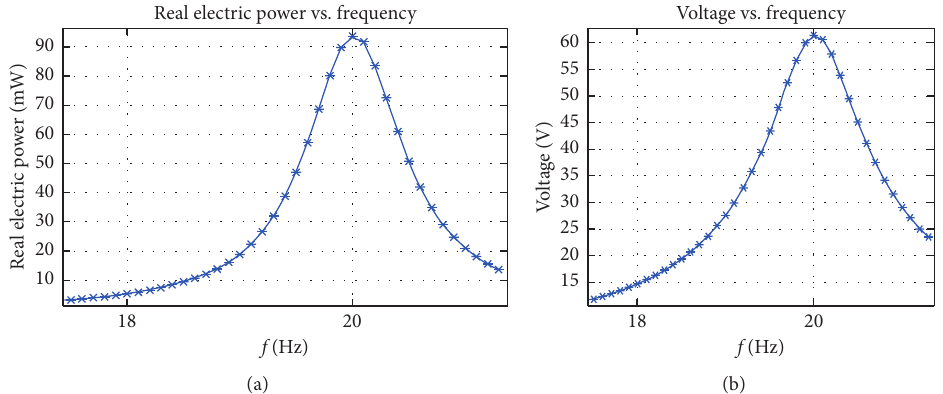
Figure 6: Electric power output vs. vibration frequency of the second trapezoidal bimorph two-piece design (a). Voltage vs. vibration frequency of the second trapezoidal bimorph two-piece design (b). W 1 is 40mm and W 2 is 18mm. The full-width half-maximum is 2.5Hz. The quality factor is 28. The structure loss factor is 0.025. The damping ratio is 0.017. The optimal resistance is 0.08M Ω . The length of the beam L is 60mm, the thickness of T piezo is 0.3mm, and the thickness of the brass layer T s is